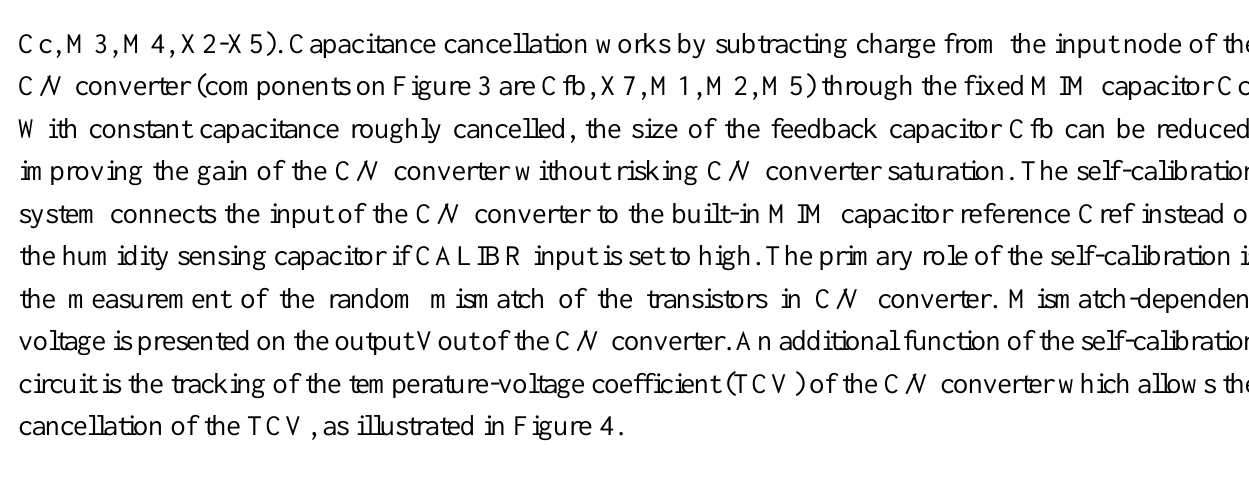
Figure 3. Schematic of the CMOS humidity sensor.